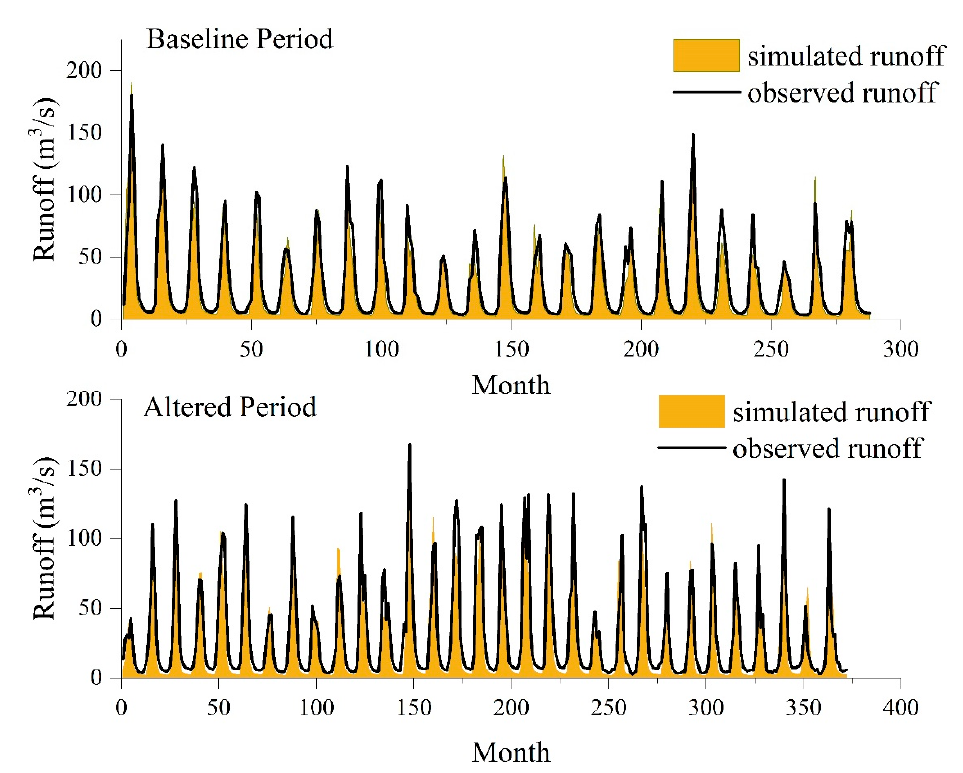
Figure 8. Monthly runoff simulation results using the improved ABCD model at Lhasa Hydrological